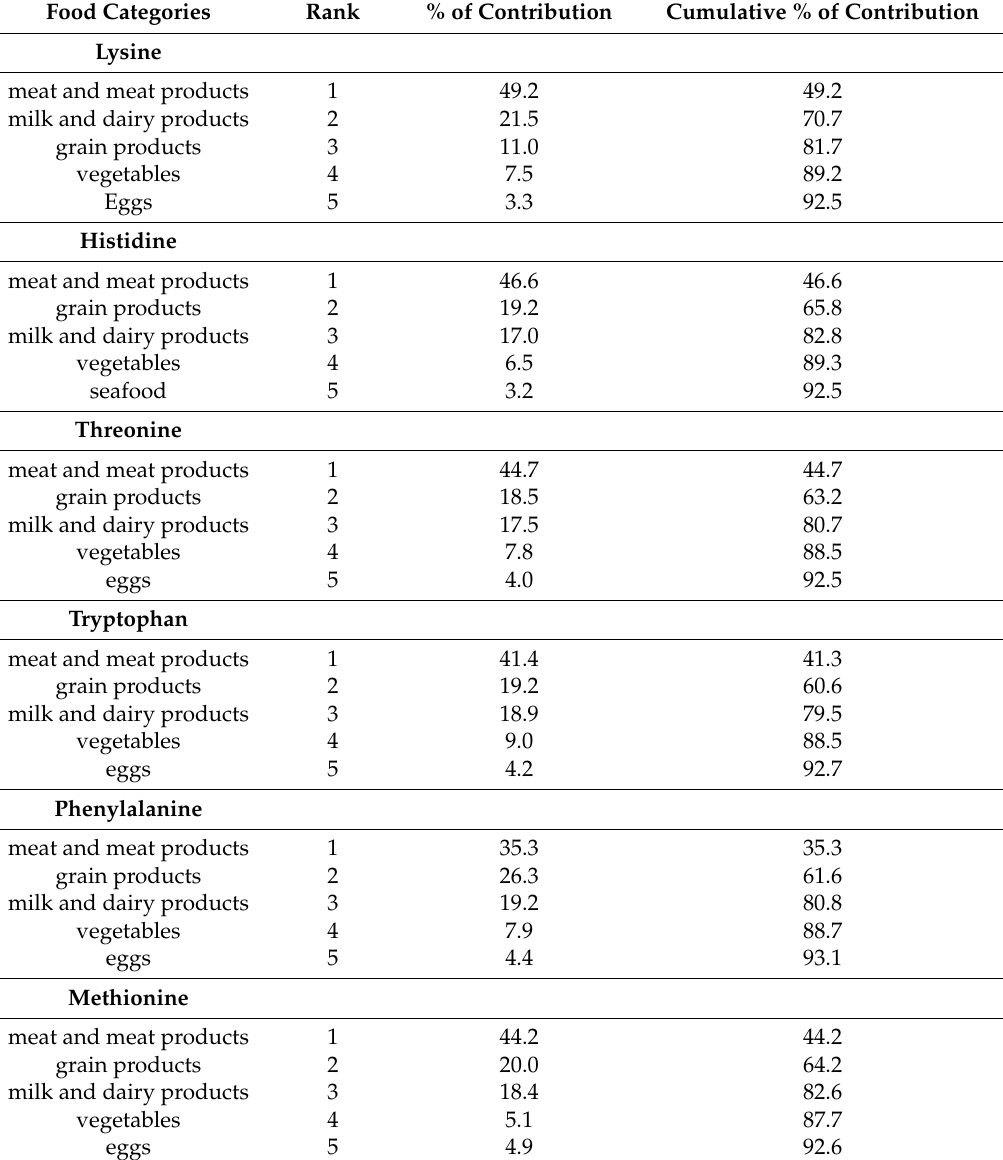
Table 4. Main food category sources of the contribution of lysine, histidine, threonine, tryptophan, phenylalanine, and methionine to the average Polish